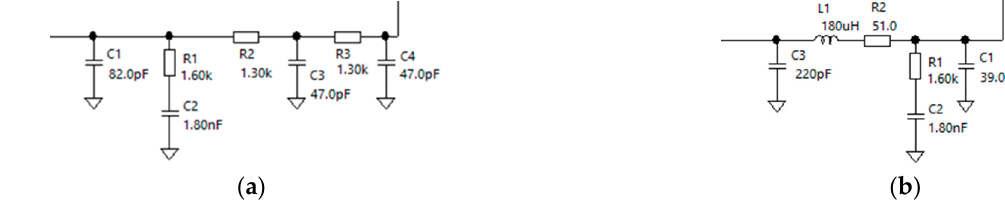
Figure 3. Loop structure: ( a ) passive fourth-order RC filter and ( b ) passive fourth-order RLC